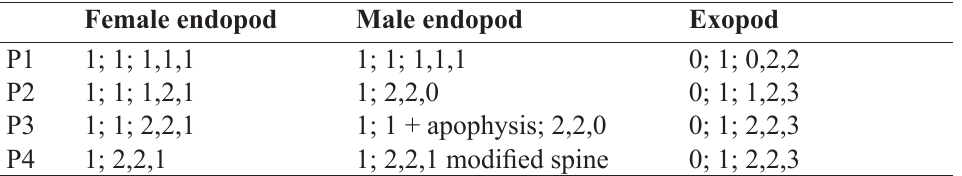
Table 2. P1–P4 armature of Canthocamptus waldemarschneideri sp.